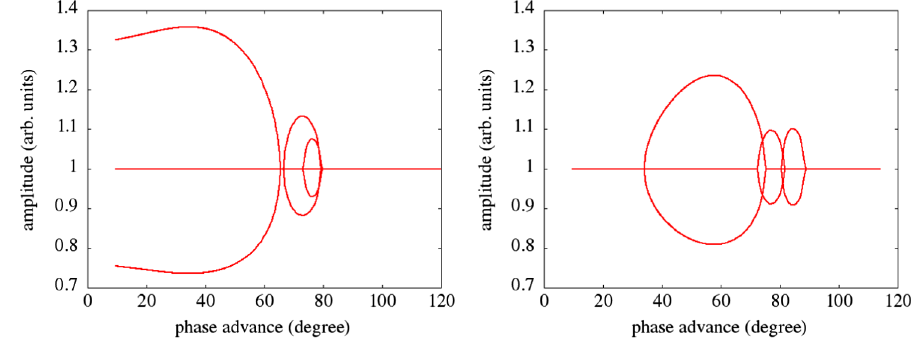
FIG. 2. The 3D envelope mode growth rate amplitudes as a function of depressed transverse phase advance with 120 degree zero current transverse and longitudinal phase advances in the periodic solenoid-rf channel without acceleration (left) and with 8 MV = m accelerating gradient (right).